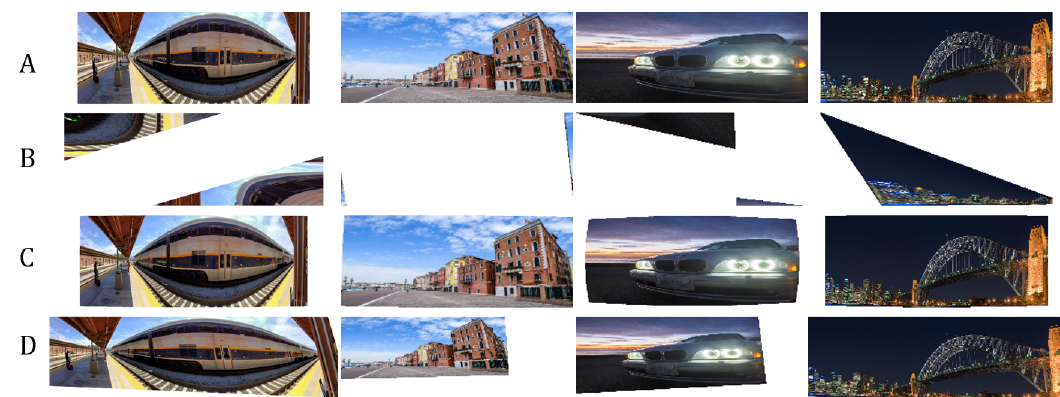
Figure 15. Results of distortion correction using public panoramic images from the Internet. ( A ): Panoramic images. ( B ): Corrected image using the technique of Chaudhury et al. [21]. ( C ): Corrected image using the technique of Li et al. [11]. ( D ): Corrected image using our method. Panoramic images often have a combination of different types of distortions. Our network still attempts to correct the images’ orientation and reduced stretching on some areas. Rightmost image taken by David Iliff